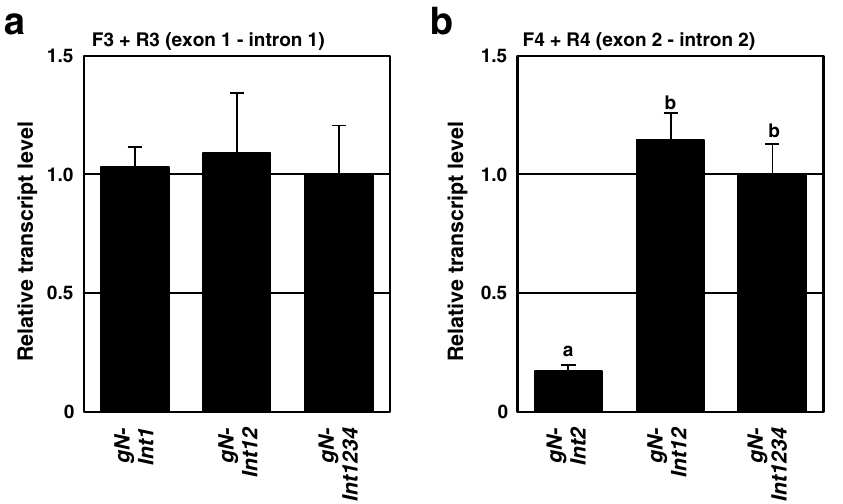
Figure 5. Involvement of intron 1, but not intron 2, in the enhanced accumulation of premature transcripts. Agrobacterium transformants carrying a plasmid for gN-Int1 , gN-Int2 , gN-Int12 , or gN-Int1234 were infiltrated to nn tobacco. Intron-containing premature transcripts from these N transgenes at 48 h post-infiltration were quantified by RT-qPCR with the F3 + R3 primer set amplifying a portion of the exon1—intron 1 junction ( a ) or the F4 + R4 primer set amplifying a portion of the exon 2 – intron 2 junction ( b ). The transcript levels of gN-Int1234 were adjusted to 1 with levels for other treatments relative to these values. Transcript levels of actin were used for normalization of values in ( a , b ). Values are the means ± SE of three biological replicates. Data in ( a , b ) were analyzed by the two-way ANOVA test followed by the Tukey–Kramer test (p < 0.05). Different letters above the bars in ( b ) indicate that the means are significantly different at the 0.05 level. Absence of letters in ( a ) indicates no significant difference between values.